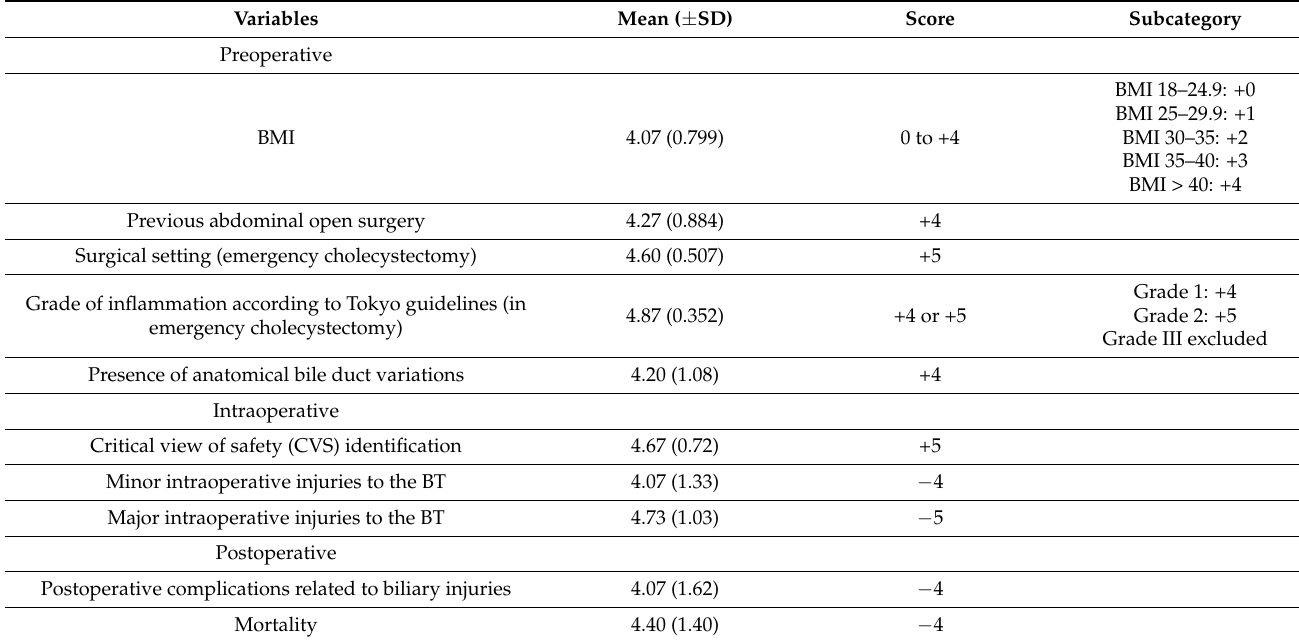
Table 3:BMI: body mass index; CVS: critical view of safety; BT: biliary tree; SD: standard